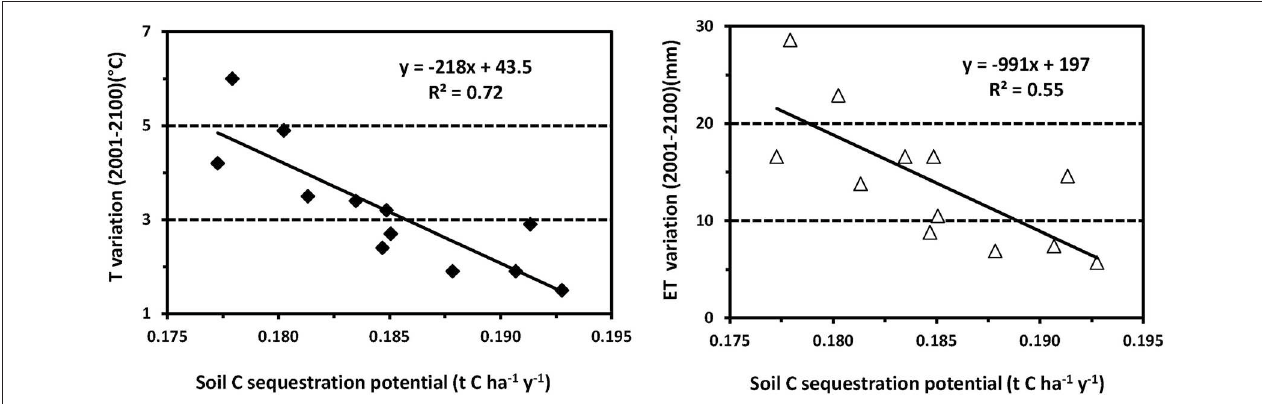
FIGURE 4 | Correlations between changes in temperature (T) and evapotranspiration (ET) predicted by 12 different climate scenarios between 2001 and 2100 and mean C sequestration potential of amended Italian agricultural soils.